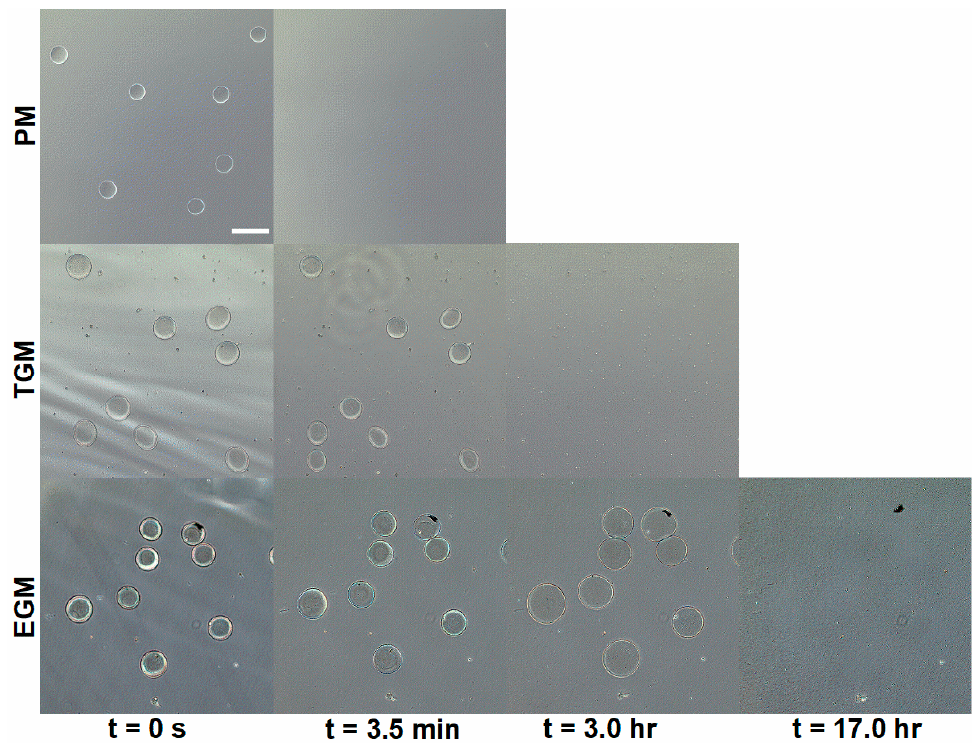
Figure 5. Degradation times of microspheres in 1.6% pectinase solution. The scale bar represents 400 µ m.